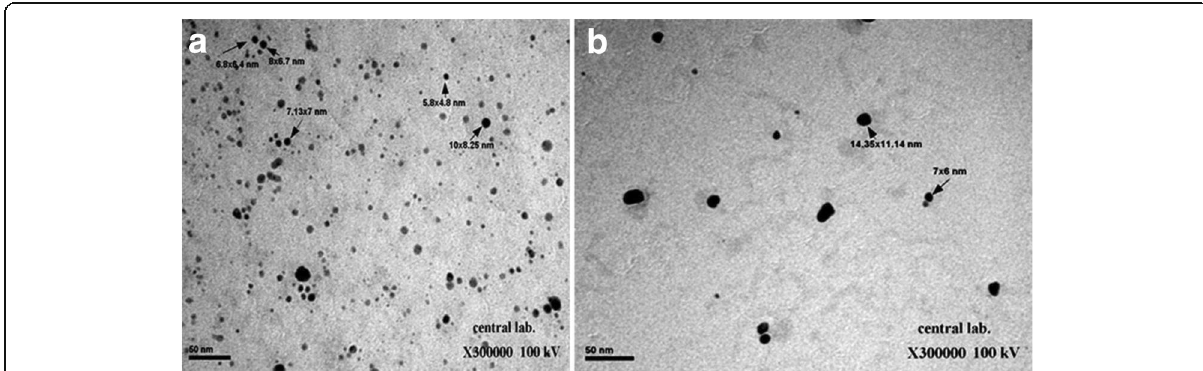
Fig. 6 TEM image of silver nanoparticles produced with Trichoderma longibrachtium after filtration of a 10 g fungal biomass and b 15 g fungal biomass